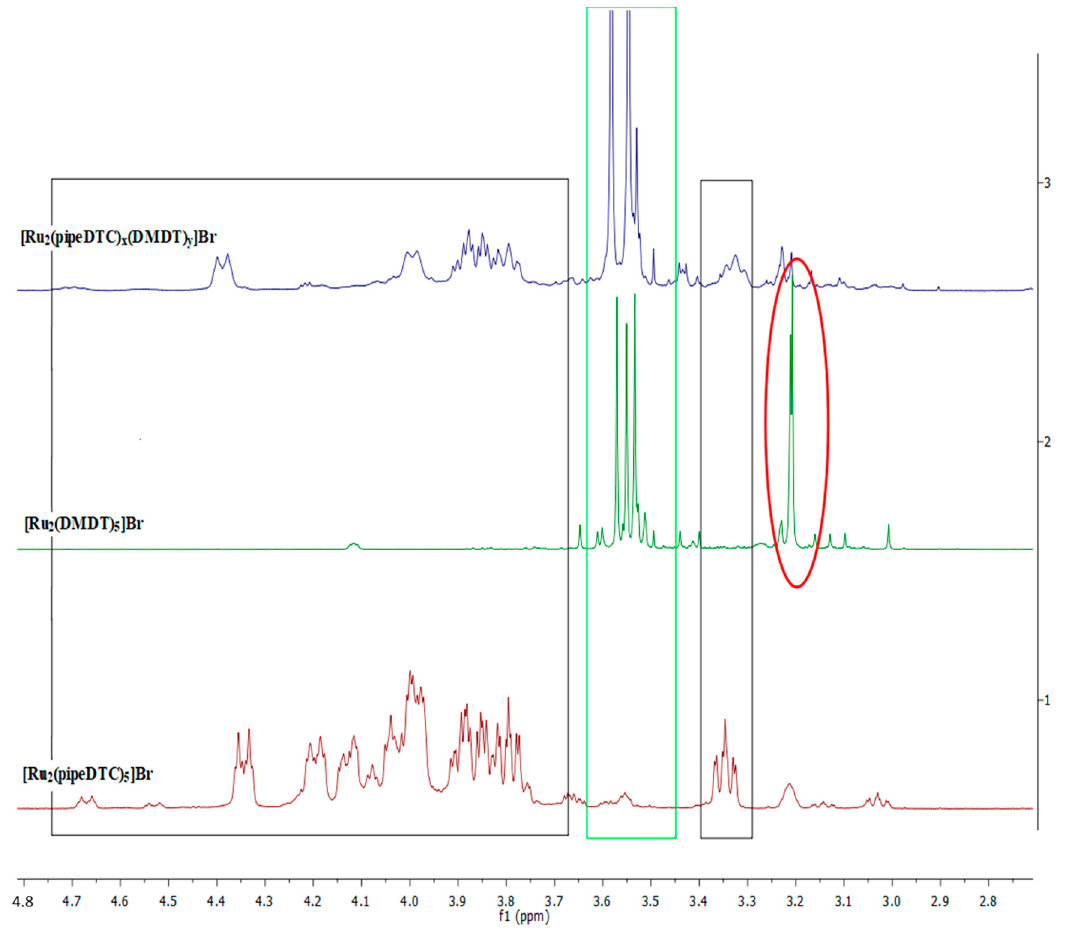
Figure 8. Comparison of the 1 H-NMR spectra of [Ru 2 (pipeDTC) 5 ]Br, [Ru 2 (DMDT) 5 ]Br and [Ru 2 (pipeDTC) x (DMDT) y ]Br. In the spectrum of [Ru 2 (pipeDTC) x (DMDT) y ]Br some resonances related to coordinated DMDT are not represented (red circle). The remaining DMDT signals are within the green rectangle, whereas the black boxes emphasise the coordinated pipeDTC signals.